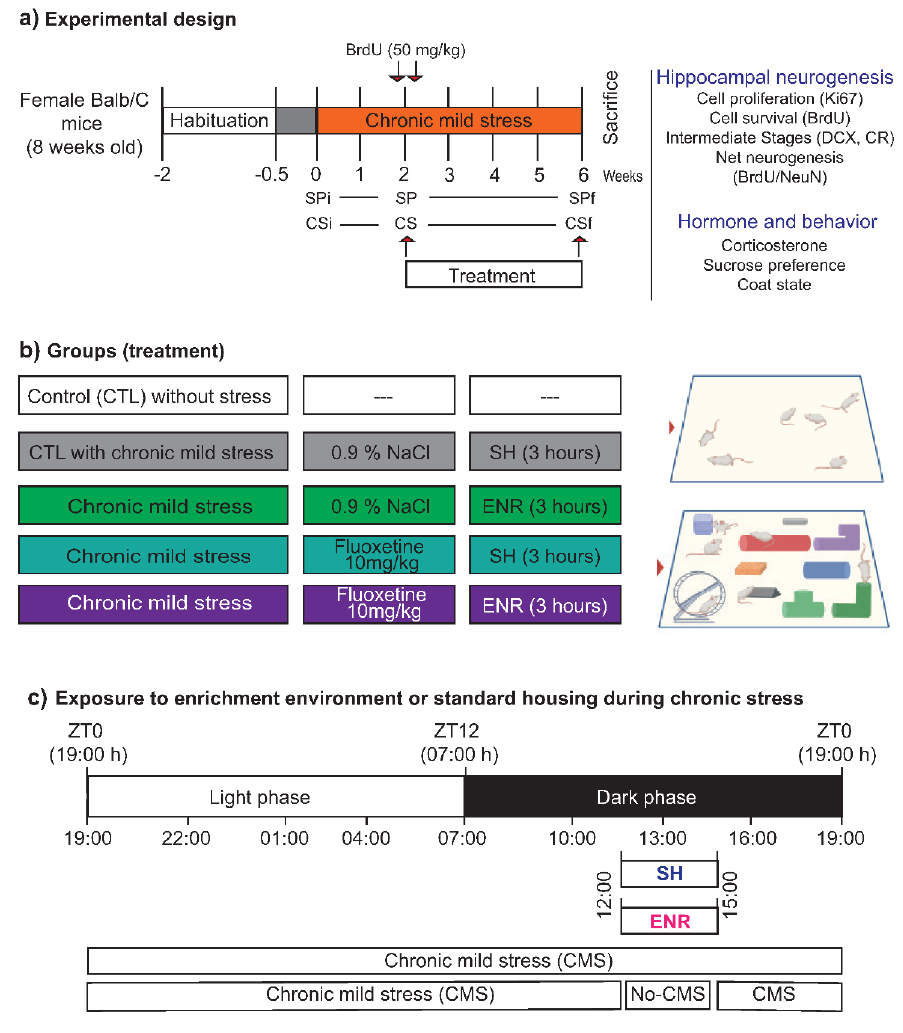
Figure 1. Experimental design. BALB/c female mice were maintained under normal housing until the age of 8 weeks. ( a ) Mice were exposed to chronic mild stress for 6 weeks. After the second week of chronic mild stress, mice were treated with vehicle (CTL), fluoxetine, environmental enrichment (ENR), or the combination of fluoxetine and ENR ( a , b ). All drugs or saline were injected at 7:00 h. During the chronic mild stress (CMS) protocol, the coat-state (CS) and sucrose preference (SP) of the BALB/c mice were evaluated initially, during the first week, (CSi or SPi), at one time point during the second week of the CMS protocol (CS or SP), and at a final time point (CSf or SPf). At the beginning of the second week, mice received two injections of BrdU (50 mg/kg; i.p.). ( c ) The exposure time along the day in which environmental enrichment (ENR) or standard housing (SH) were applied are shown. Illustrations were created with